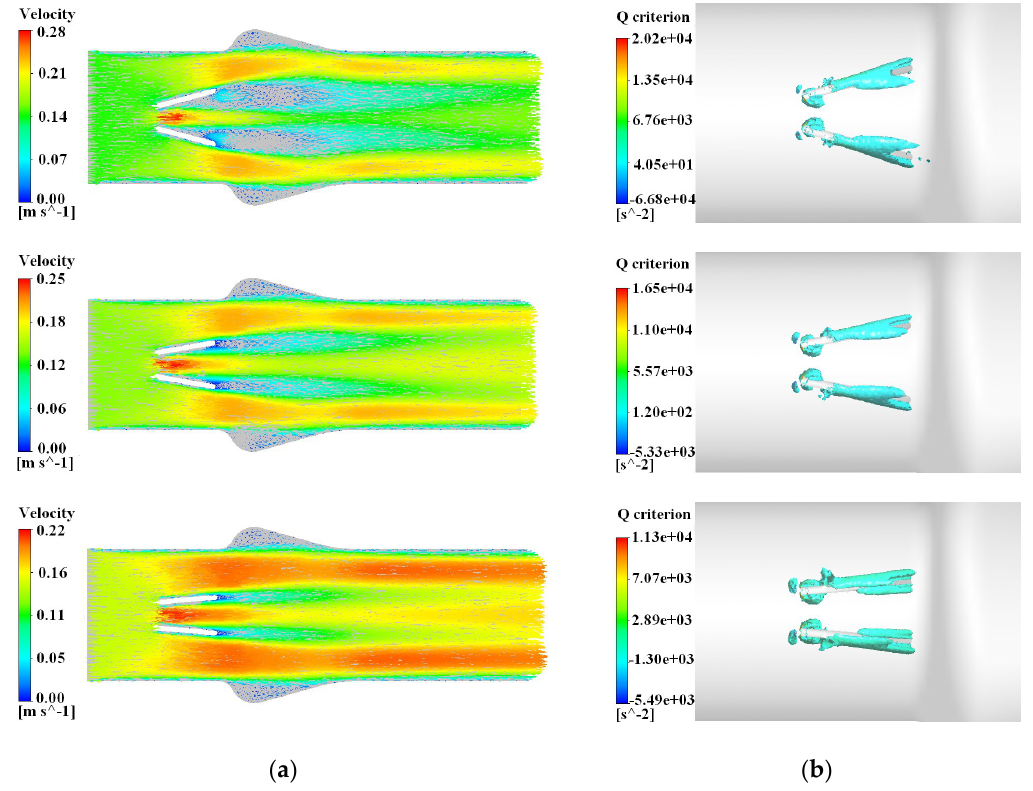
Figure 7. Velocity vector distribution and Q criterion of the vortex core region of the different angle bileaflet mechanical heart valves (BMHVs) at a flow rate of 5 L / min. ( a ) Velocity vector distribution. opening angle bileaflet mechanical heart valves (BMHVs) at a flow rate of 5 L/min. ( a ) Velocity vector ( b ) Q criterion of vortex core distribution. ( b ) Q criterion of vortex core region.